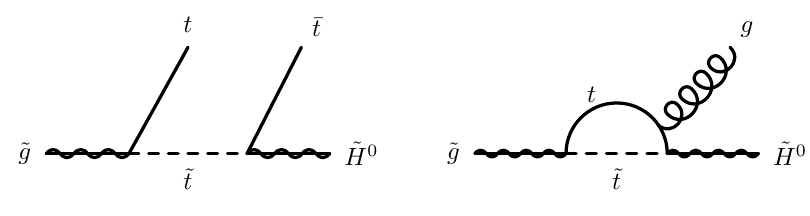
Figure 2 . Tree-level and one-loop decays of the